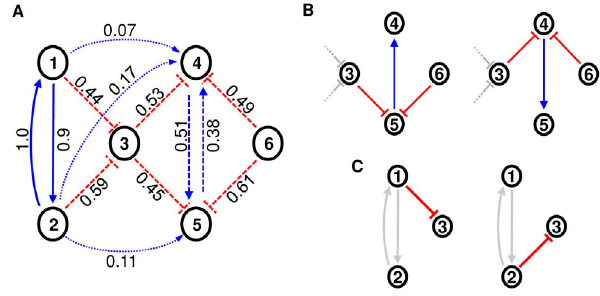
Figure 2. Illustration of an ensemble. An ensemble of several hundred predicted networks is created by calculating the frequencies of interactions. Reverse-engineering algorithms may produce suboptimal predictions, thus a certain amount of (random) variations in network topologies has to be expected. A) Ensemble average with annotated relative frequencies for activating (blue) and inhibiting (red) interac- tions. High confidence interactions (bold) are present in nearly all networks. High confidence non-interactions (dotted) are missing in most. Interactions present in subsets of networks have intermediate frequencies and are considered as low confidence interactions. B) Interactions connecting genes 3 to 6 constitute two characteristic sets (low confidence interactions). Either the left set of interactions or the right one is realized in predicted networks, but no mixture of sets or subsets. The co-occurrence of these interactions is not apparent in the ensemble. C) Interactions affecting gene 3 are mutually exclusive, but do not co-occur with other interactions. They can occur in combination with any of the characteristic sets and constitute an unspecific, highly variable sub-region of predicted